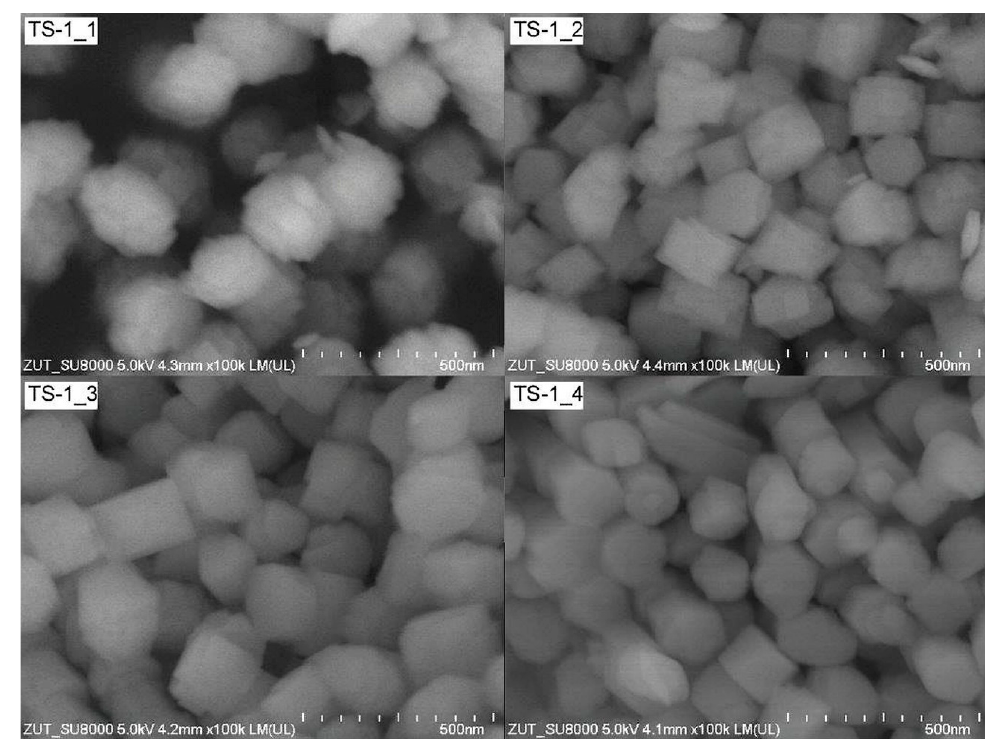
Figure 4. SEM pictures of TS-1 materials.